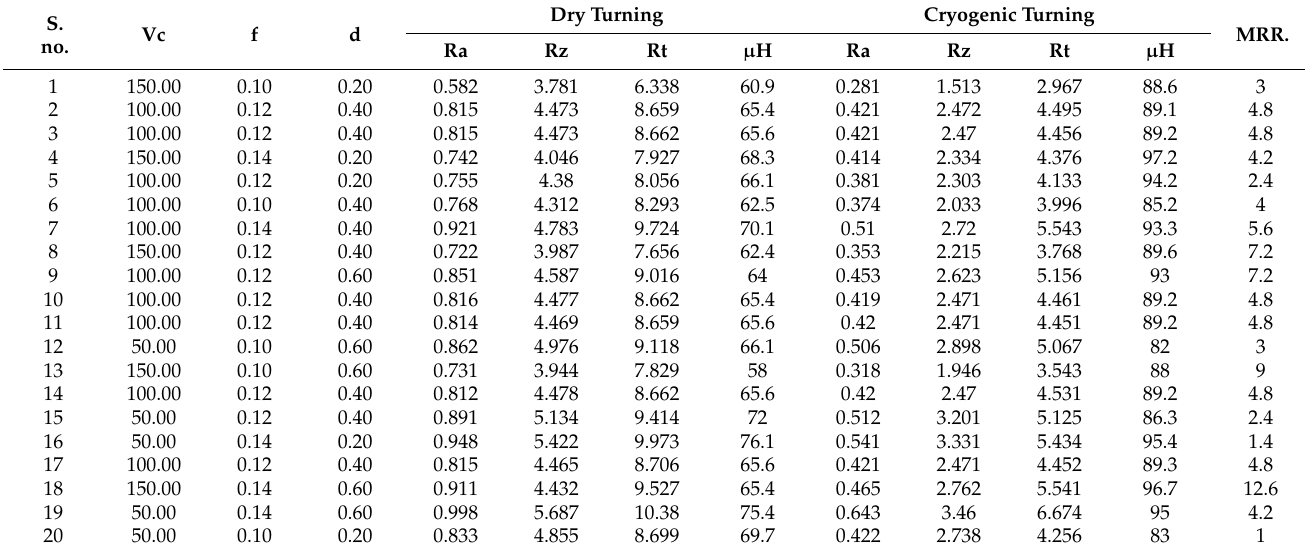
Table 4. Turning parameters, cooling techniques and response